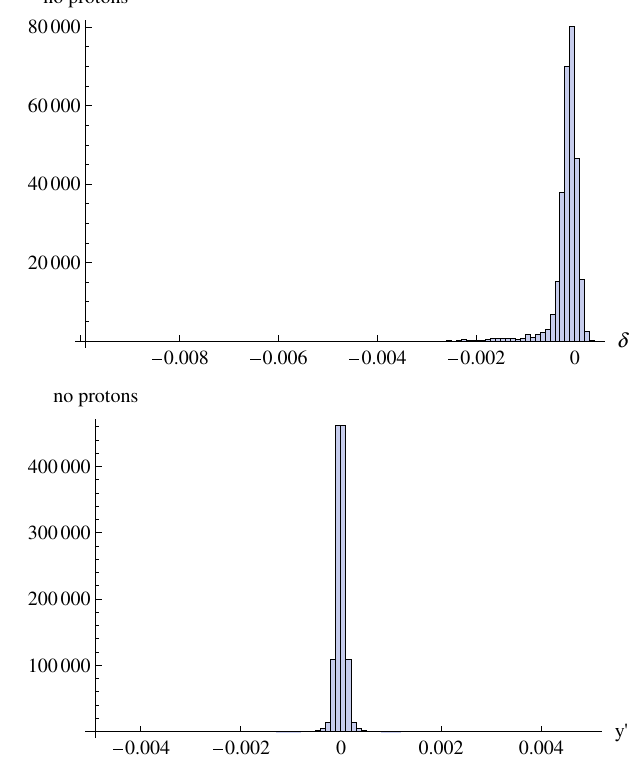
FIG. 20. (Color) The simulated distribution of (cid:8) (top) and y 0 (bottom) of all protons coming out of the